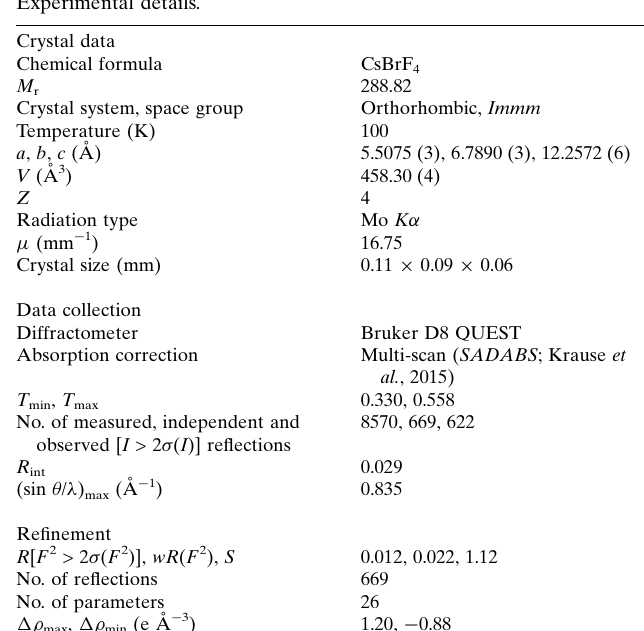
, y + 1 , z + 1 ; (iv) x (cid:2) 1 , 2 2 2 2 , (cid:2) y + 1 , z + 1 ; (vii) (cid:2) x + 1, 2 2 2